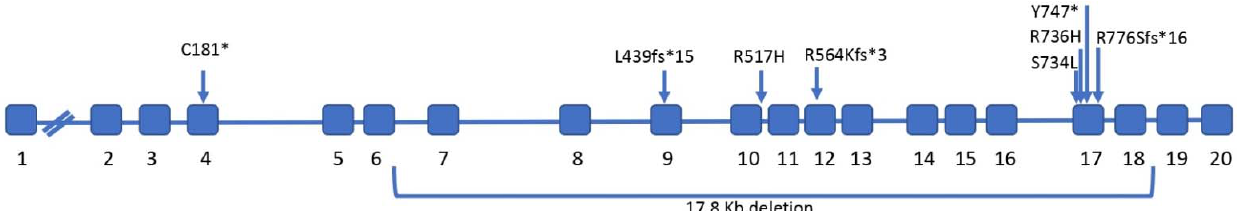
Figure 1. Majeed syndrome associated mutations. LPIN2 is composed of 20 exons. Pathogenic mutations are located throughout the gene. Most disease-causing mutations reported to date are predicted to results in early truncation or in exon deletion. Two missense mutation. The in vitro functional work by Donkor et al. showed that the mutant protein is expressed but lacked PAP